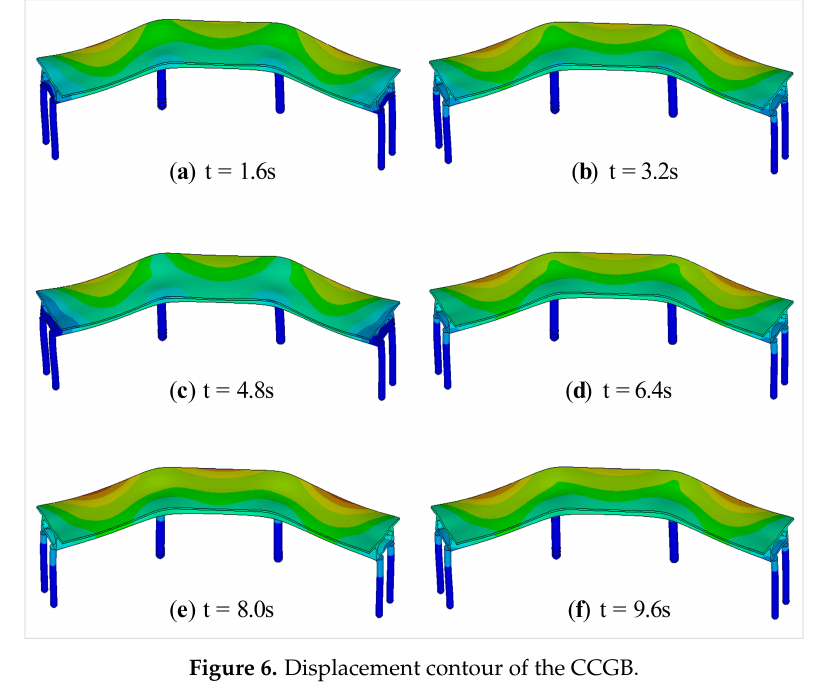
Figure 6. Displacement contour of the CCGB.